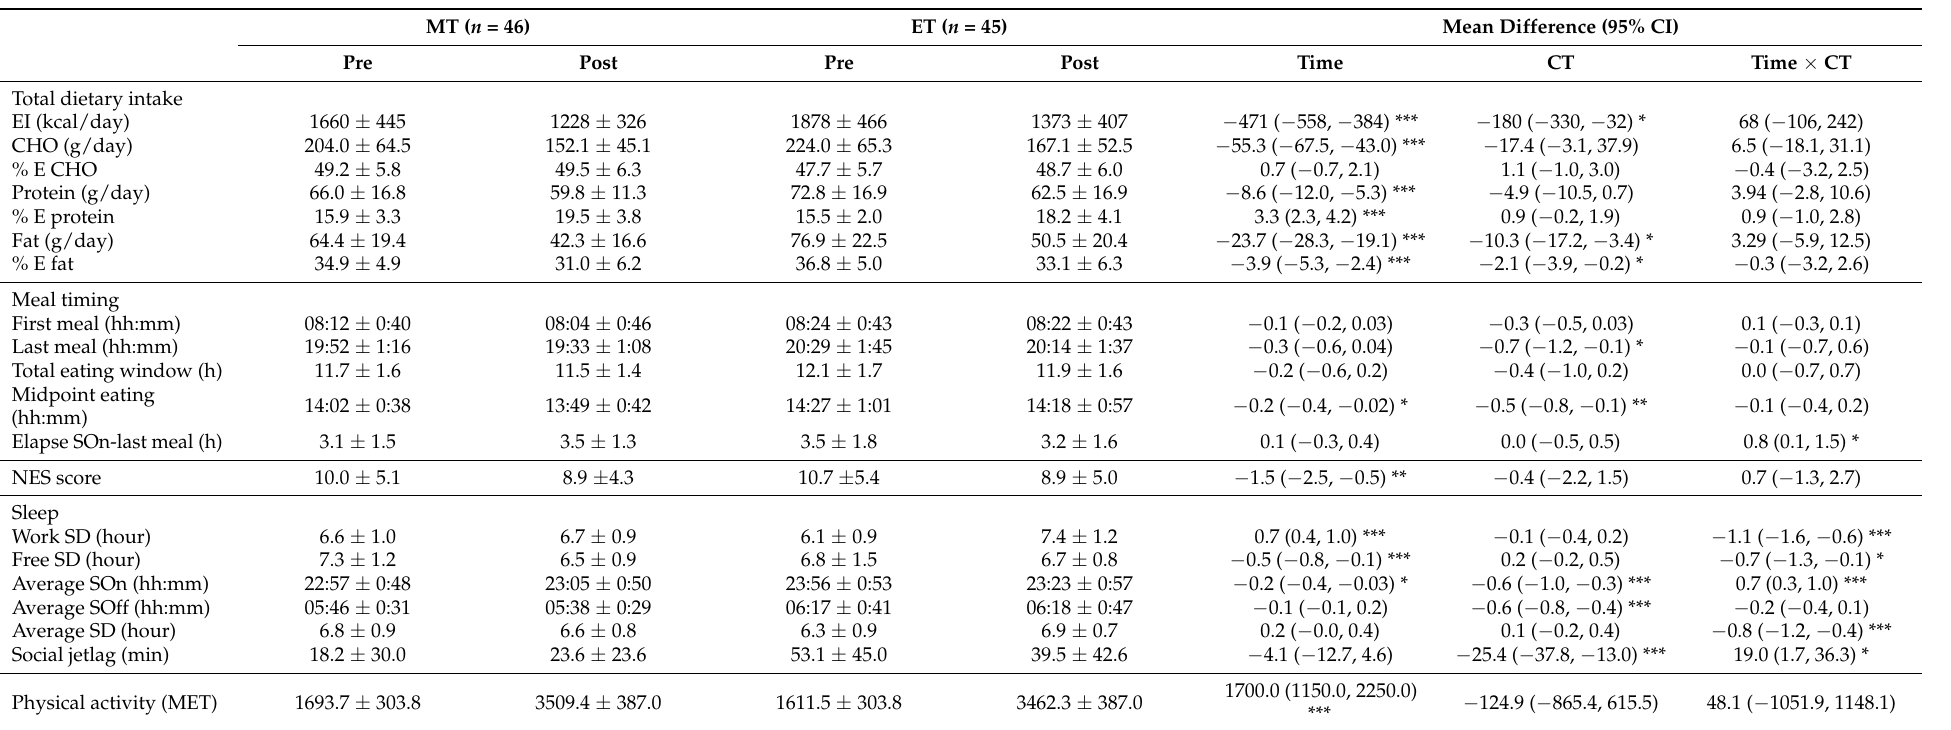
Table 4. Pre–post intervention differences in total dietary intake, meal timing, NES score, sleep habits and physical